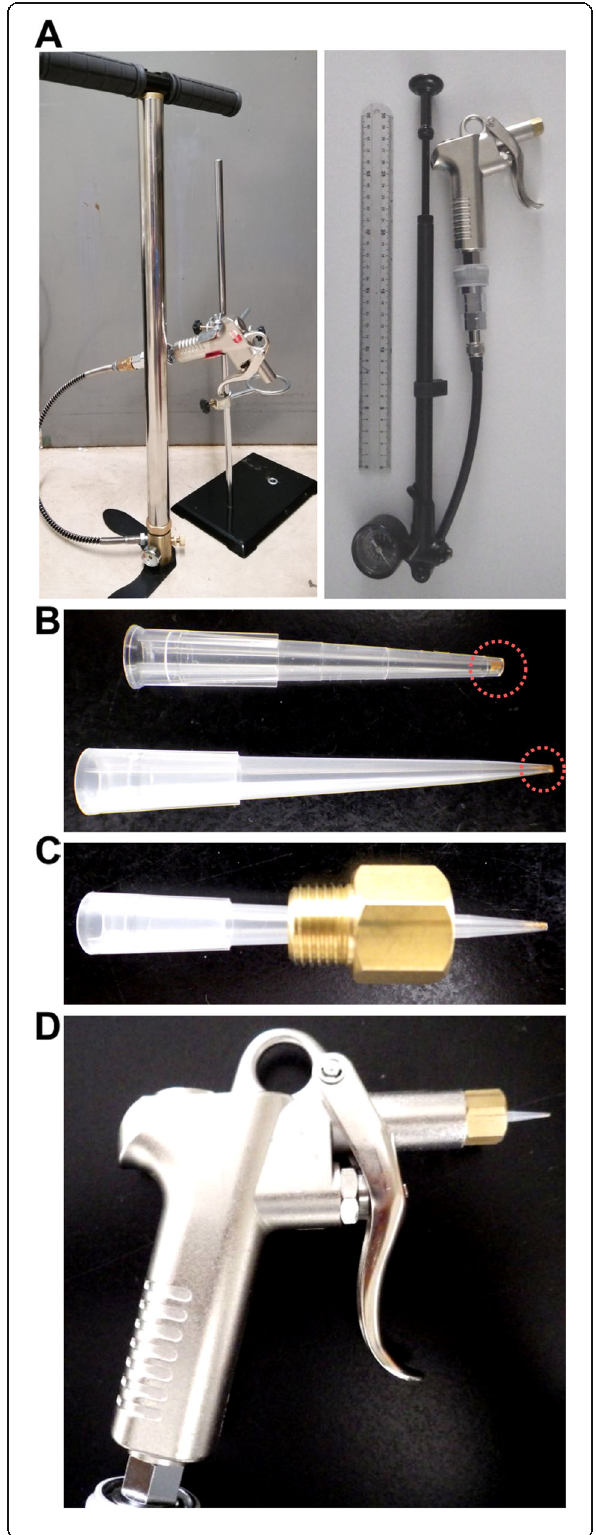
Fig. 1 Development of TSGAMAP. a TSGAMAP with a floor pump (left panel) and with a bicycle shock pump (right). The ruler in the right panel is ~ 30 cm long. b Pipette tips with DNA-coated gold particles. The end of the pipette tip in the top panel was clipped off before the gold particles were placed. c A setup to fix the pipette tip on the nozzle of the TSGAMAP air duster gun with screw fittings. d The air duster gun with the pipette tip fixed on the